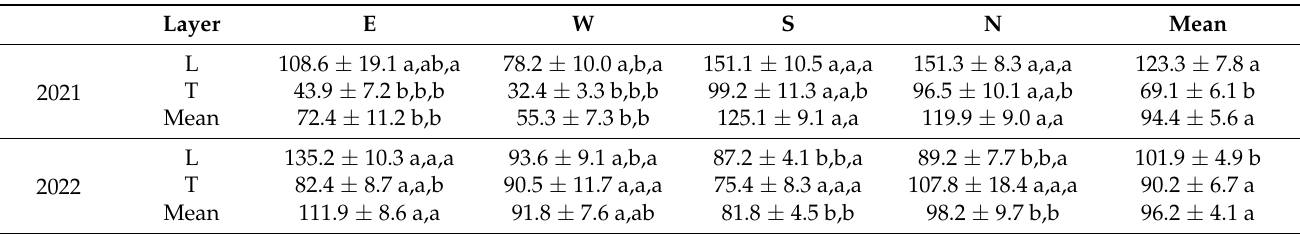
Table 4. Fruit number (n) in 2021 in different expositions (E, W, S, N) for different layers: low (L; 0.5–1.4 m) and top (T; 1.4–2.3 m). The first letters denote statistical differences between different years for an exposition and a layer; the second letters denote statistical differences between different expositions for a year and a layer; the third letters denote statistical differences among different layers for a year and an exposition ( p = 0.05; SNK